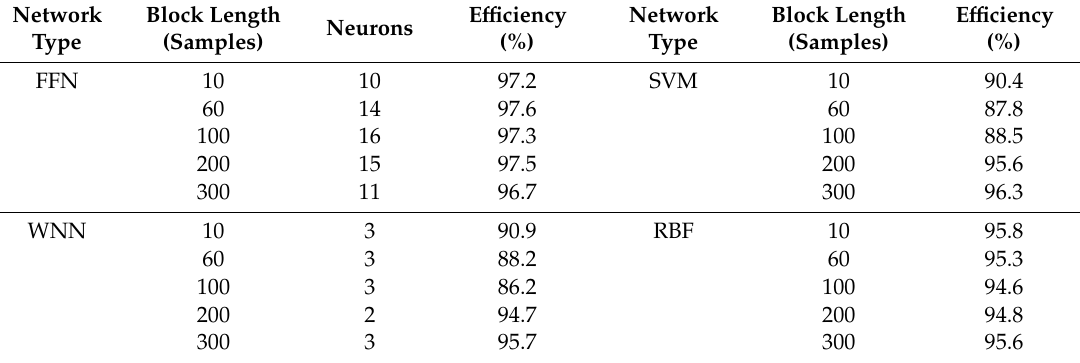
Table 1. Classification e ffi ciency test results for variable data block lengths. WNN, wavelet neural network.